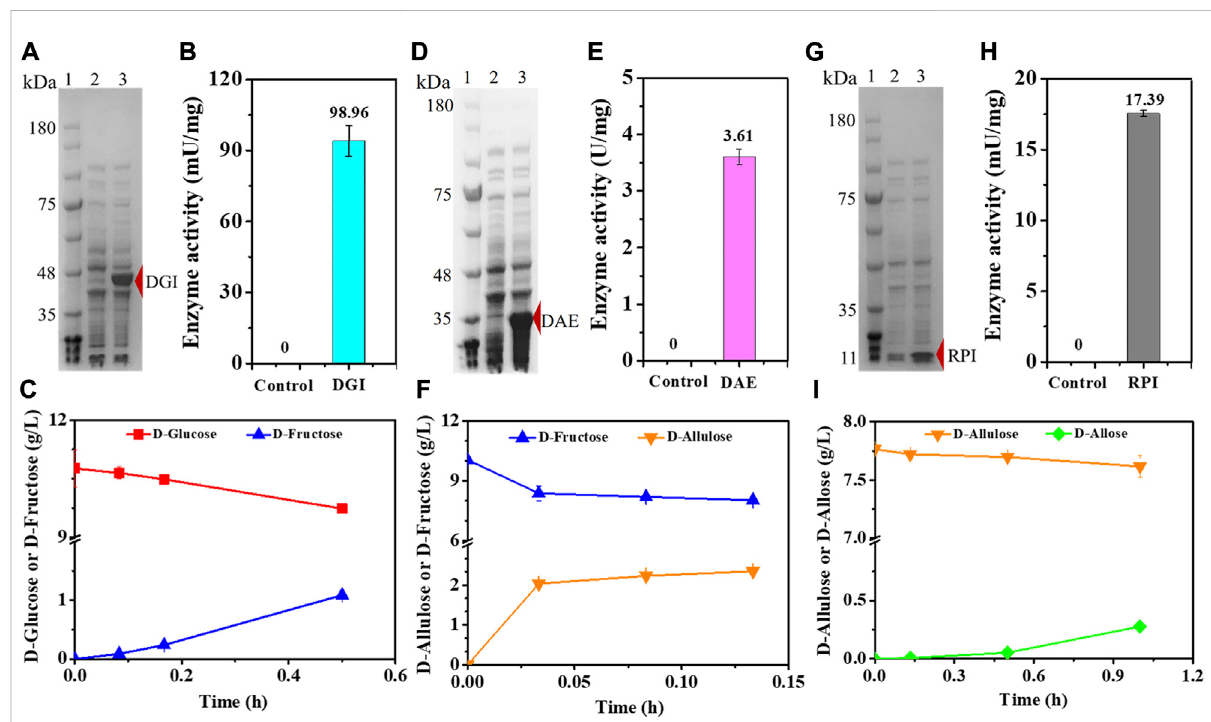
FIGURE 2 ExpressionandfunctionalityofDGI,DAE,andRPI. (A) SDS-PAGEanalysisofDGI.Lane1:Marker,Lane2: E.coli (EmptyA),Lane3: E.coli (DGI). (B) Activity of crude DGI. The supernatantof disrupted E. coli (Empty A) was used as acontrol. (C) Conversionof D-glucoseto D-fructose by crude DGI. (D) SDS-PAGE analysis of DAE. Lane 1: Marker, Lane 2: E. coli (Empty B), Lane 3: E. coli (DAE). (E) Activity of crude DAE. The supernatant of disrupted E. coli (Empty B) was used as a control. (F) Conversion of D-fructose to D-allulose by crude DAE. (G) SDS-PAGE analysis of RPI. Lane 1: Marker, Lane 2: E. coli (Empty B), Lane 3: E. coli (RPI). (H) Activity of crude RPI. The supernatant of disrupted E. coli (Empty B) was used as a control. (I) Conversion of D-allulose to D-allose by crude RPI. Error bars indicated standard error ( n =